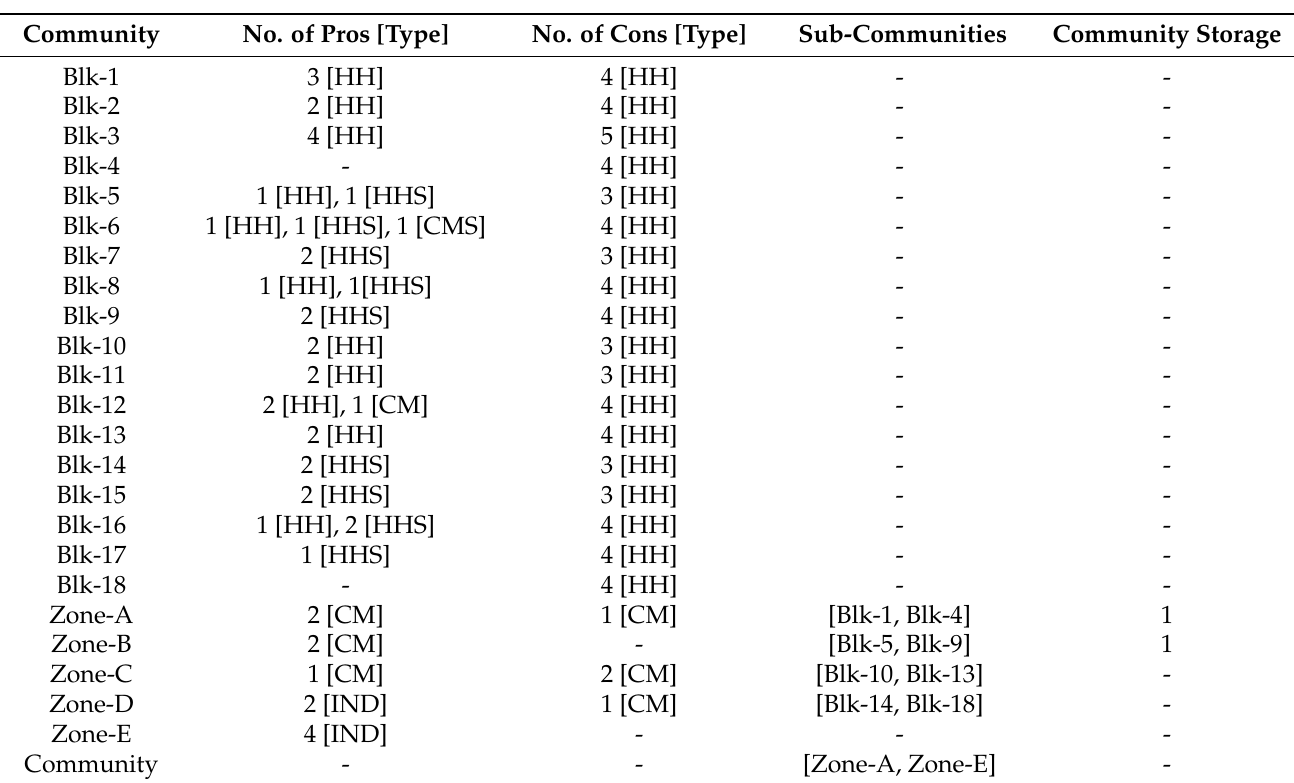
Table 2. Hierarchical arrangement of local traders.